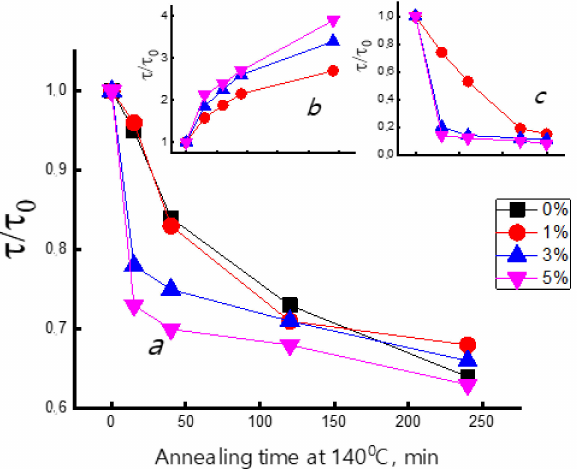
Figure 7. Dependence of the molecular dynamics expressed as relative correlation time ( τ / τ 0 ) from annealing time at 140 ◦ C for the PHB electrospun fibers with ( a ) TPP, ( b ) SnCl 2 -TPP, ( c )